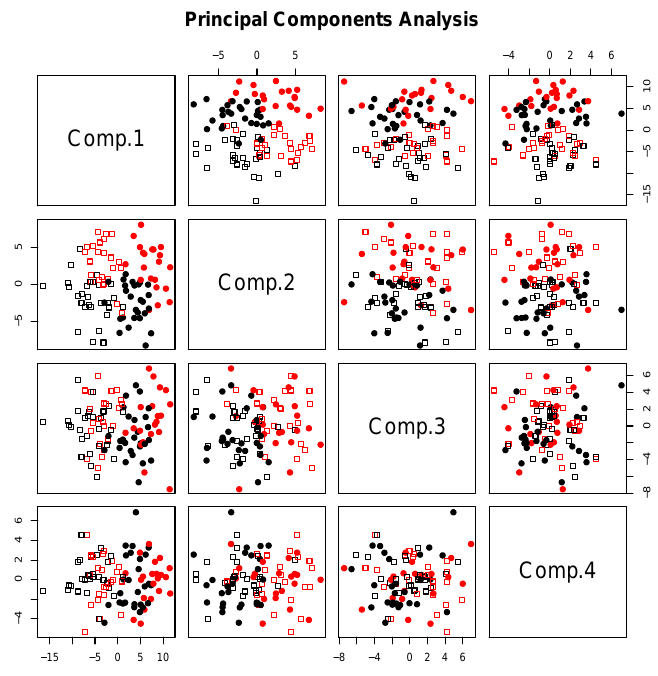
Figure 5. Scatter plot of the illustrative data on components one to four of the proimcipal component analysis (PCA).